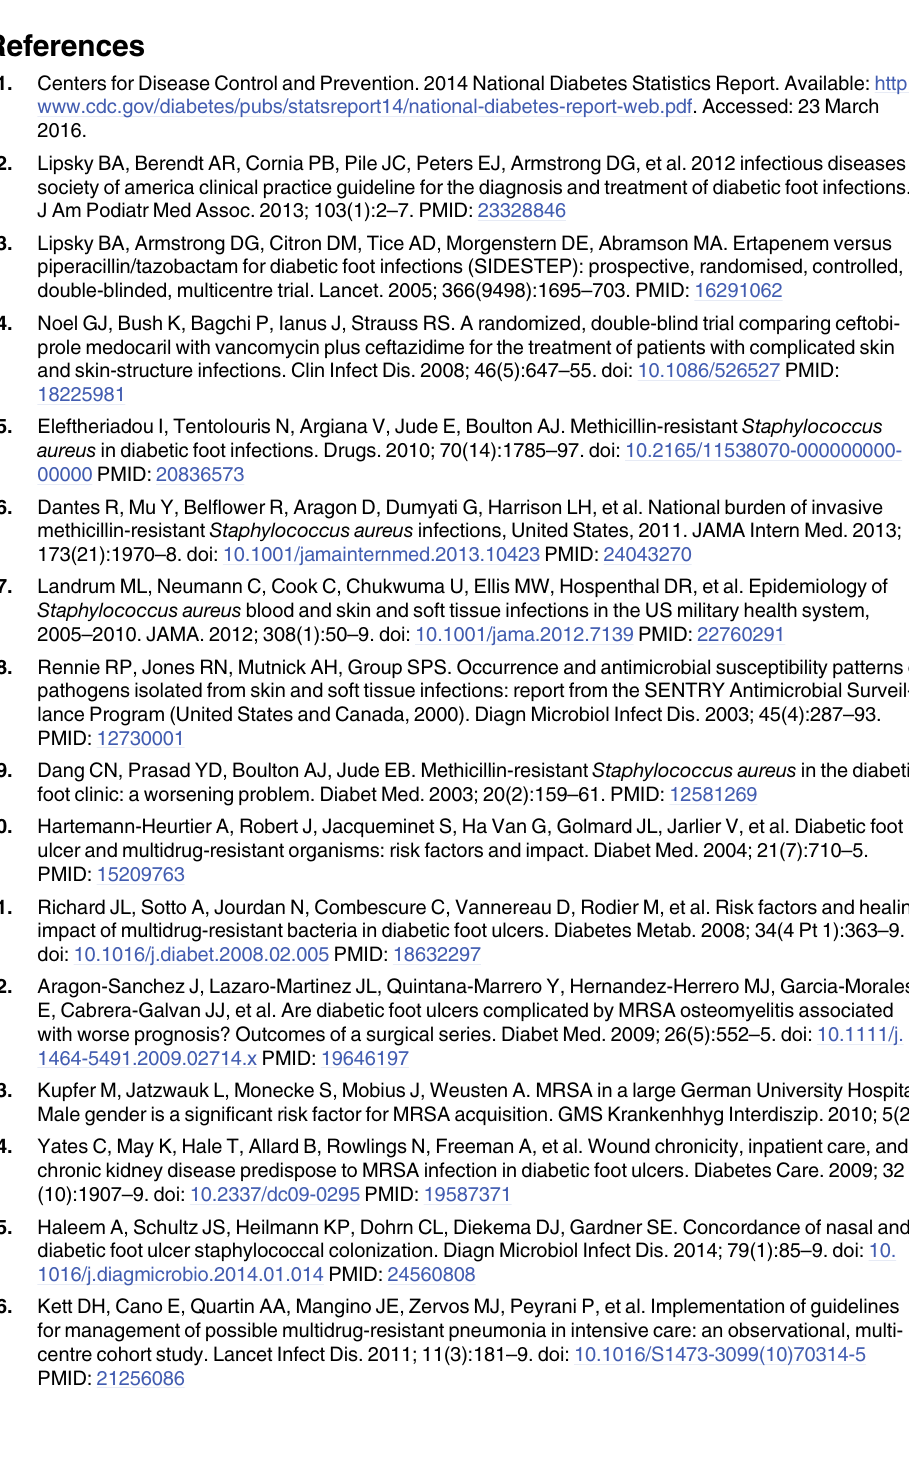
PLOS ONE | DOI:10.1371/journal.pone.0161658 August 24,